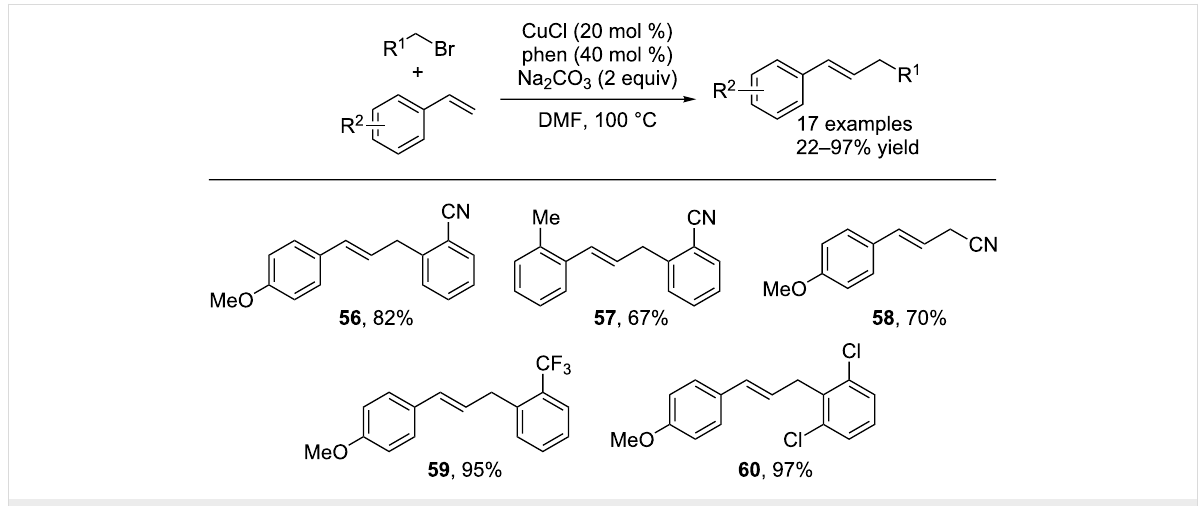
Scheme 16: Benzylation of styrenes using copper